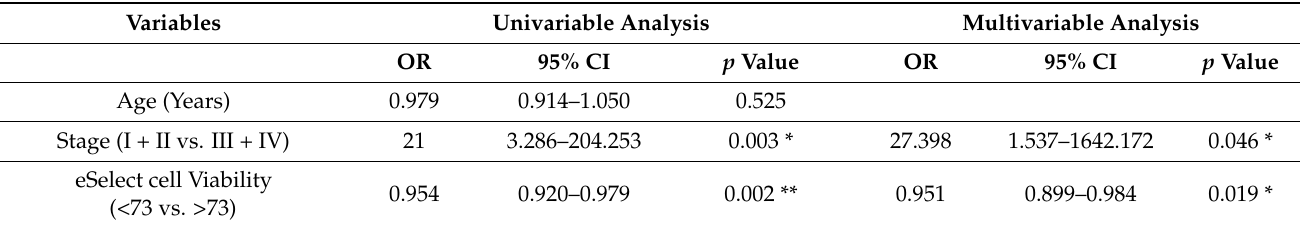
Table 3. Univariate and multivariate analyses for prognostic variables of clinical outcomes in HNC patients using logistic regression. Variables